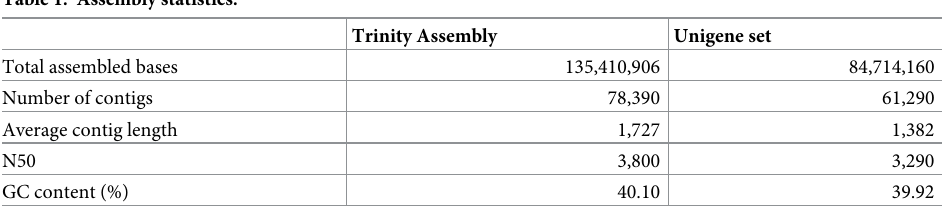
Table 1. Assembly statistics.